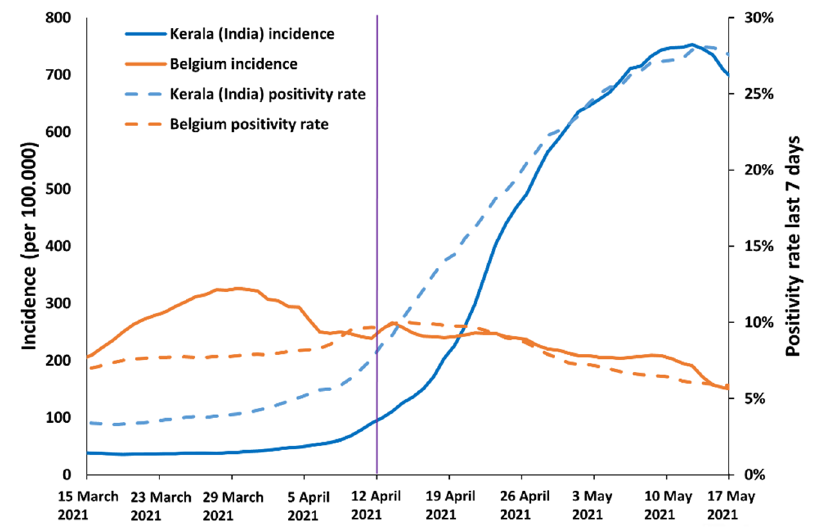
Figure 1. Incidence and 7-day positivity rate in Kerala (India) and Belgium. The date of arrival in Belgium is marked with a vertical purple line.